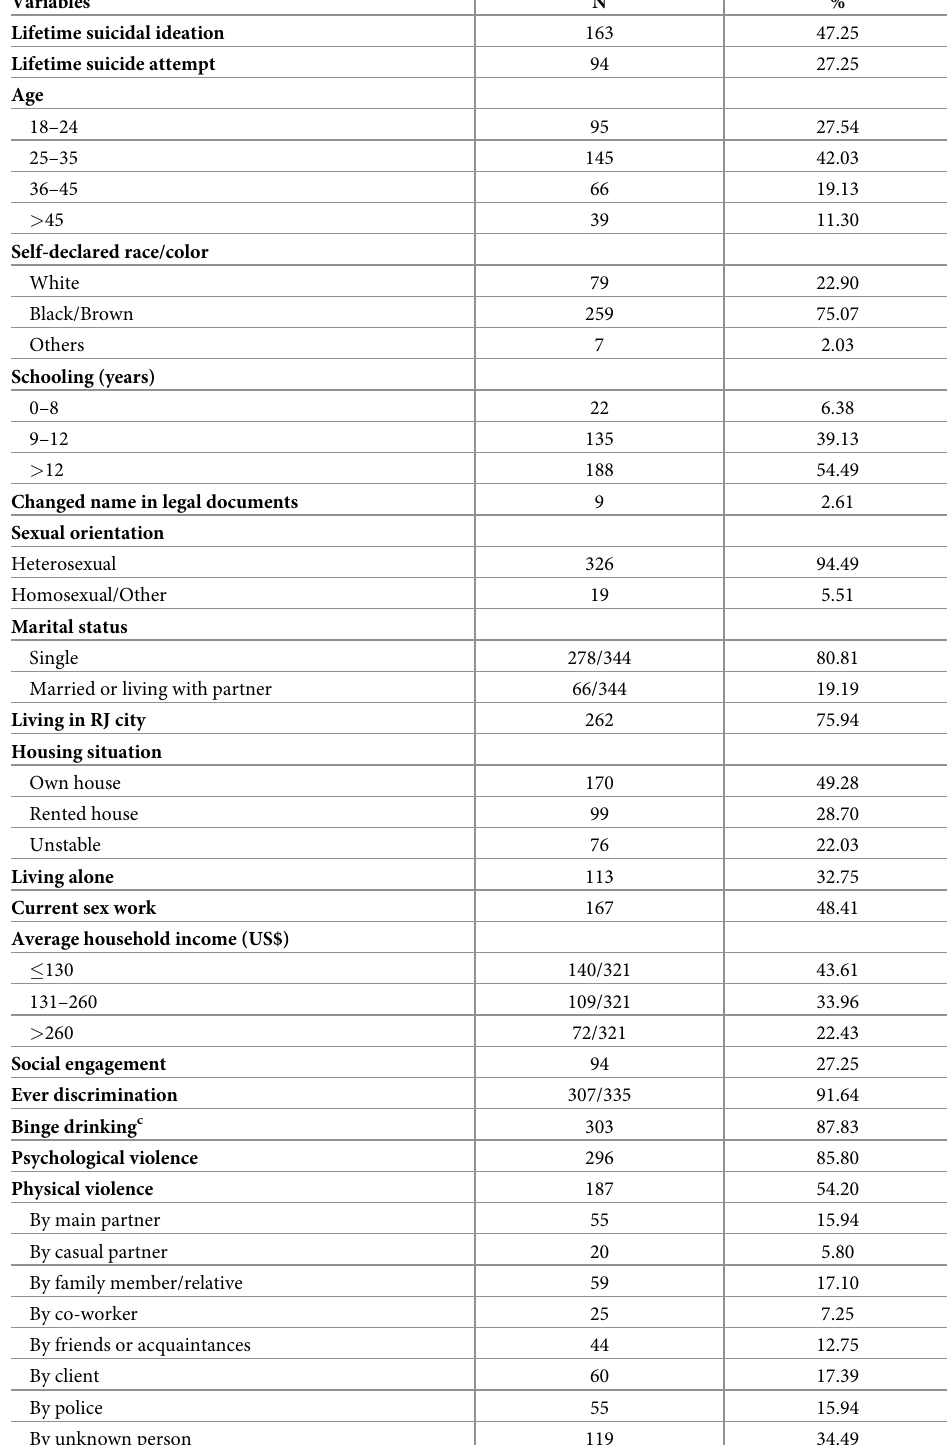
Table 1. Prevalences of lifetime suicidal ideation and suicide attempt and sample characteristics of trans women in Rio de Janeiro, Brazil, 2015–2016 (n =